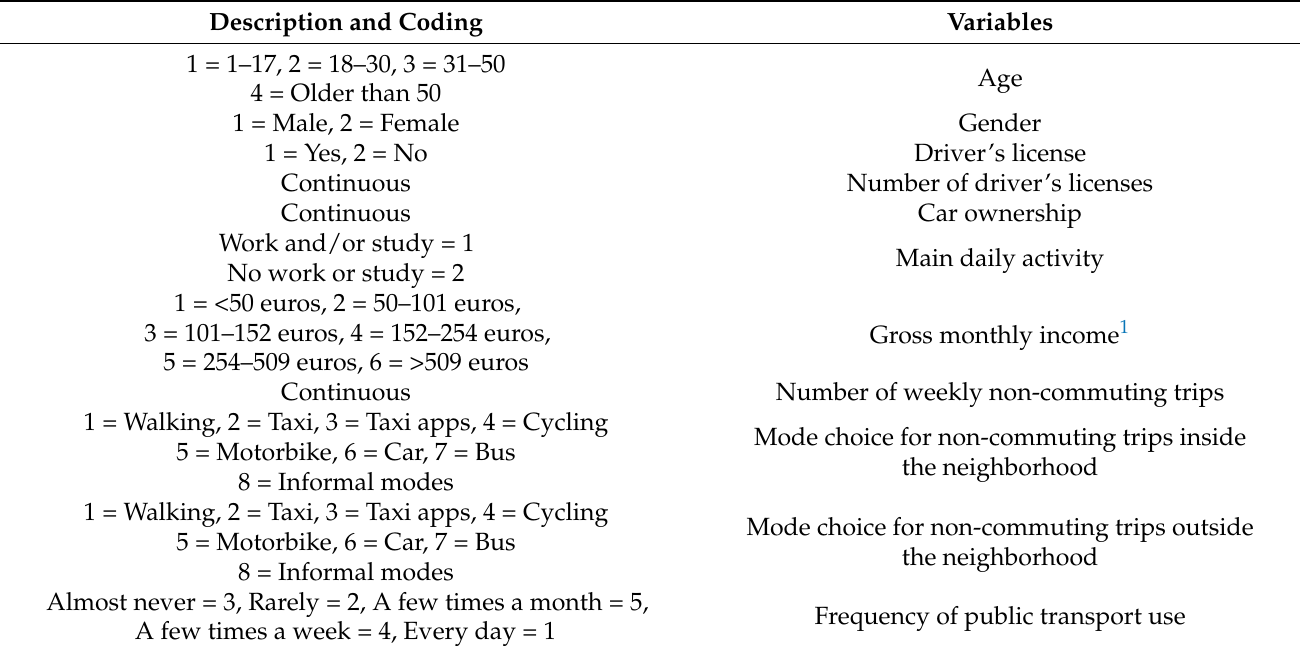
Table 1. Socioeconomic, travel behavior and perception